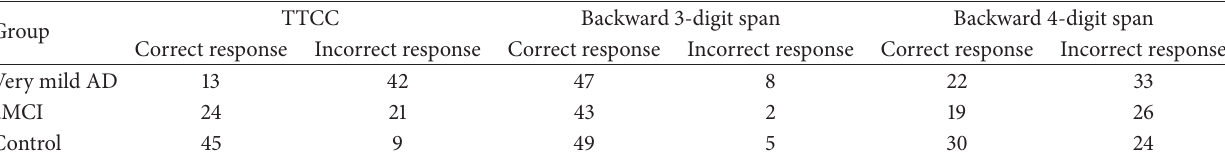
Table 2: The results of the TTCC and the reverse-backward